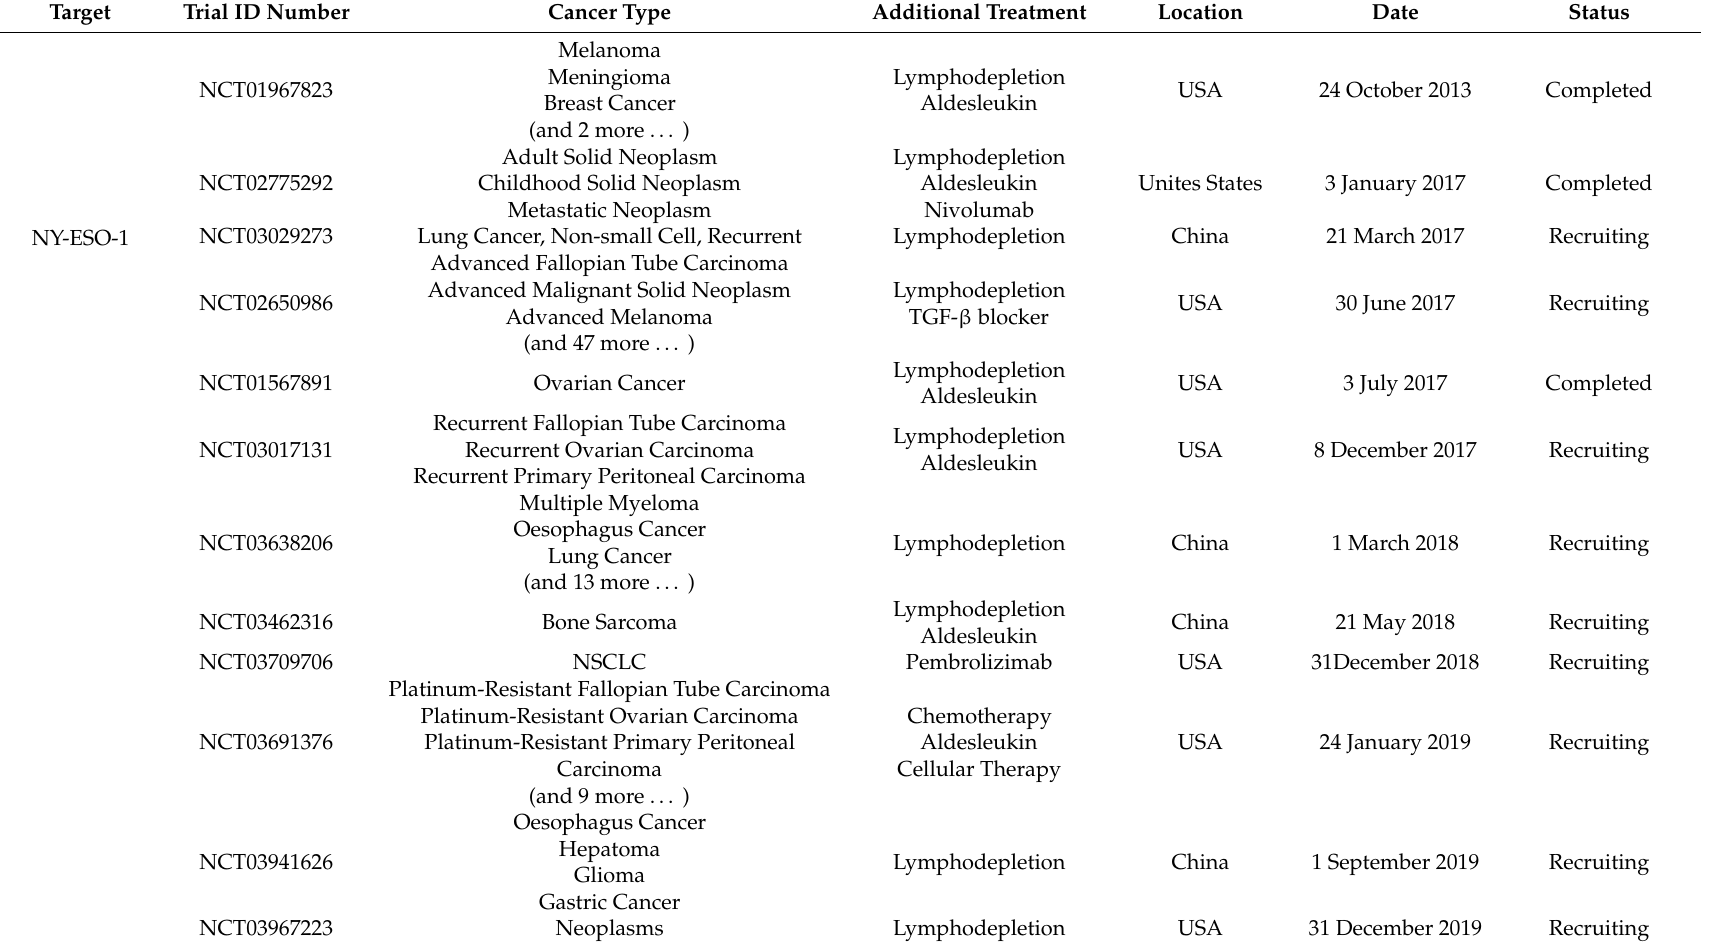
Table 1. Registered clinical trial using rTCR-T cells against solid tumors